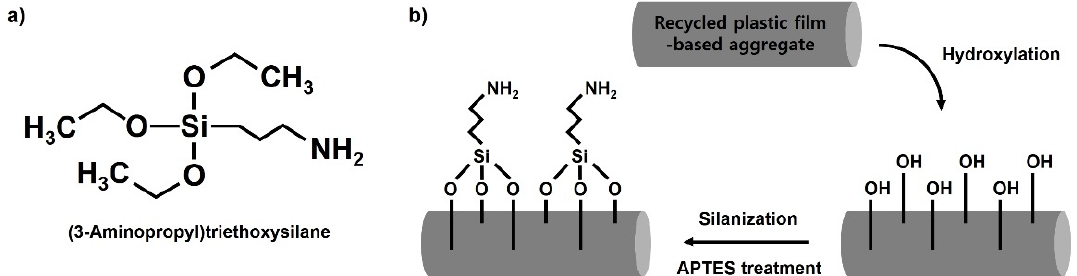
Figure 3. ( a ) Chemical structure of 3-aminopropyltriethoxysilane and ( b ) schematic illustration for the surface modification mechanism during silanization reaction.